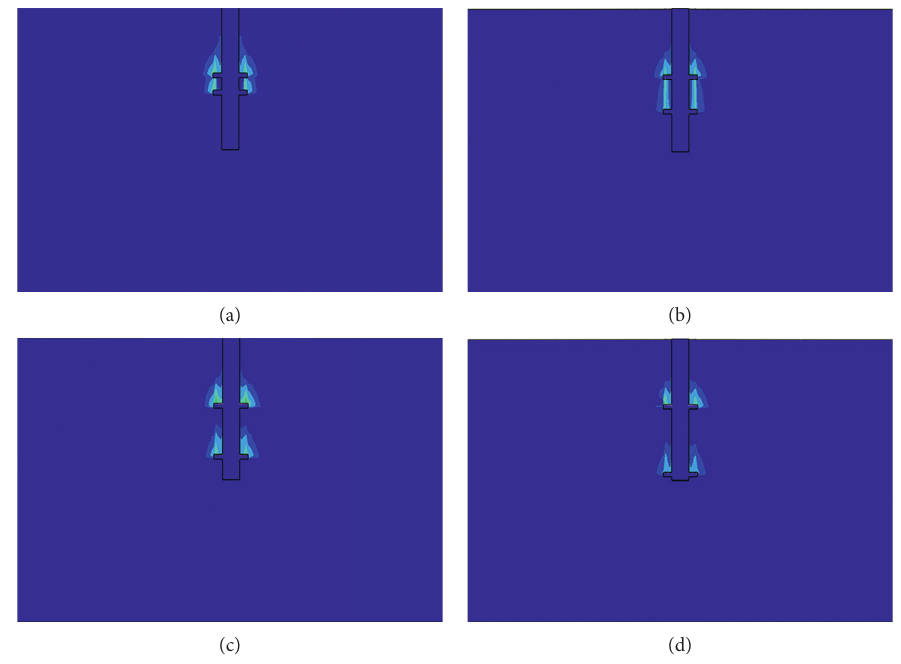
Figure 11: Plastic zone distribution of RP. (a) RP No. 11. (b) RP No. 12. (c) RP No. 13. (d) RP No.